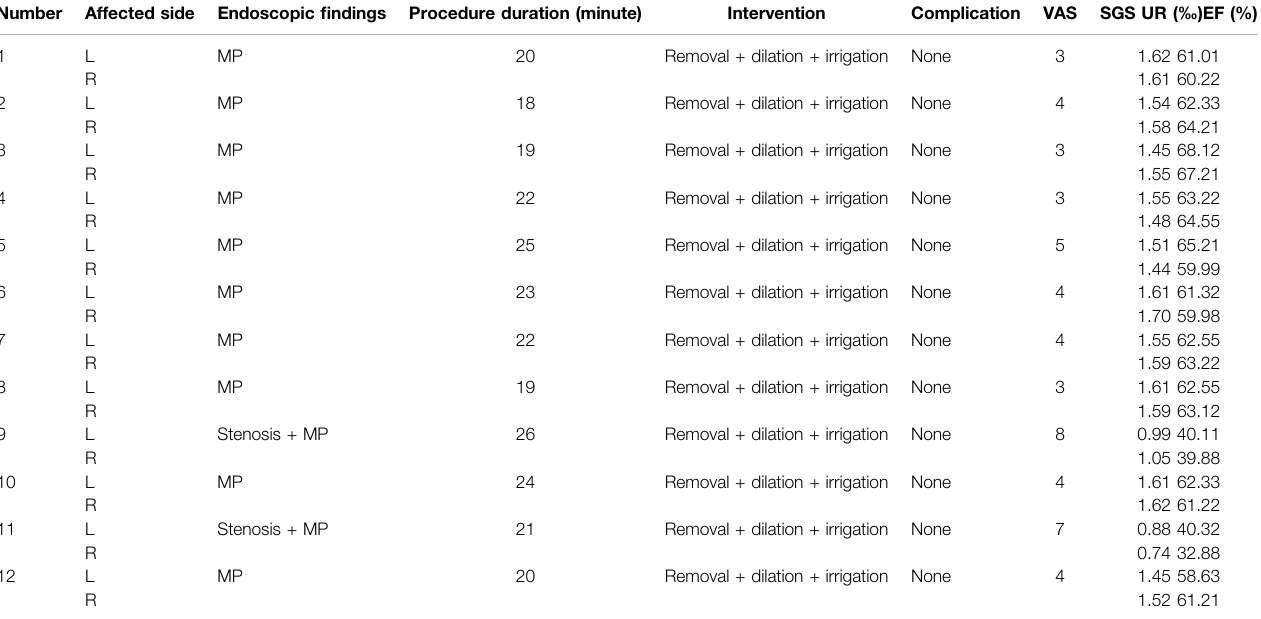
TABLE 2 | Postoperative characteristics of patients. Number Affected side Endoscopic fi ndings Procedure duration